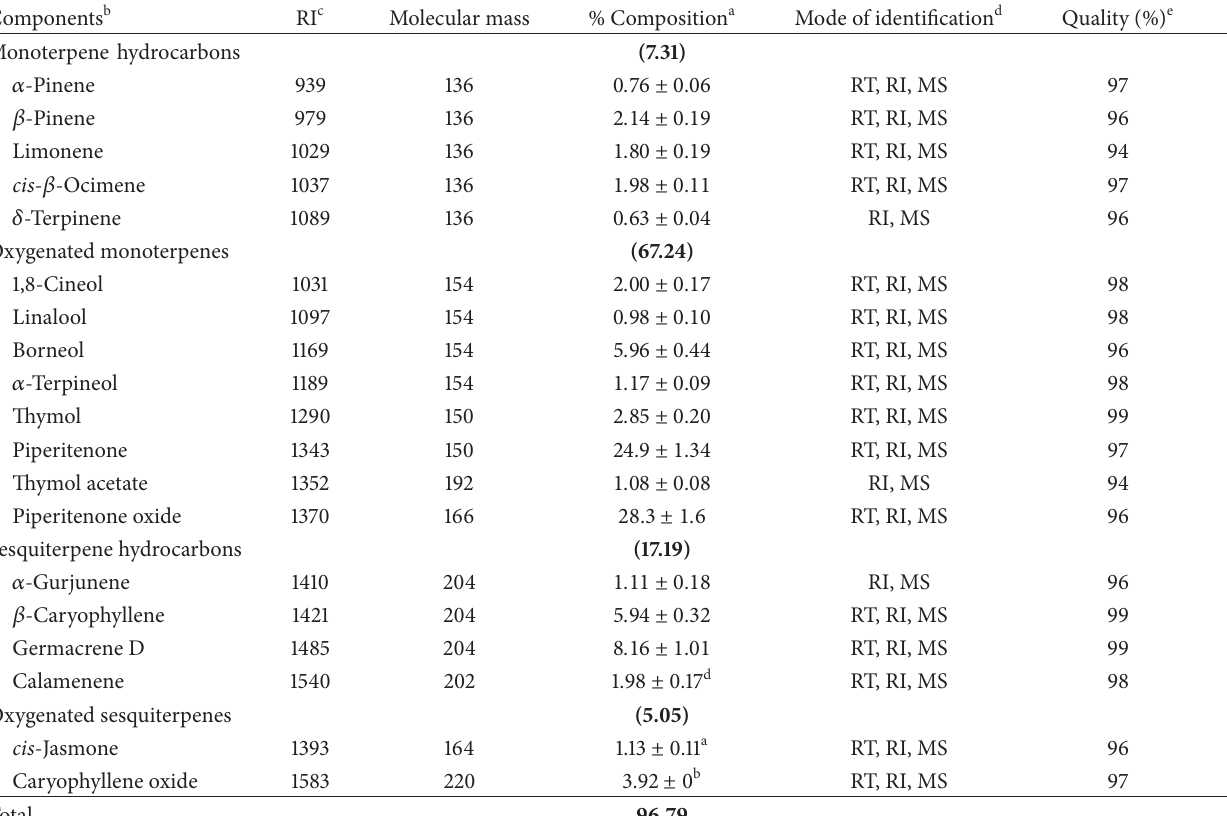
Table 2: Chemical composition of M. longifolia essential oil.